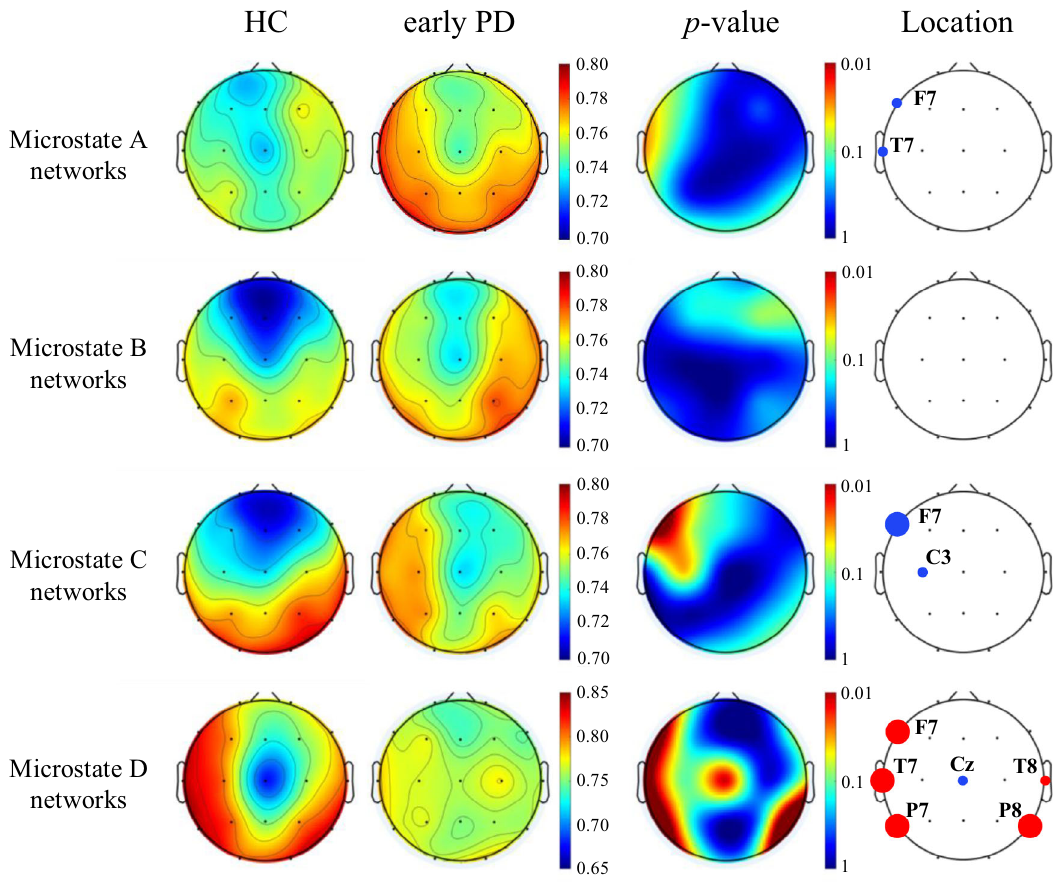
Fig. 3 Topological distribution of spatial variability of microstate functional connectivity networks (averaged over the subjects) for both groups and their differences in the four-microstate networks. The red points indicate the positions in which the spatial variability of microstate functional connectivity networks in healthy controls are obviously higher than that in early PD patients, and the blue points represent the positions that have lower spatial variability in healthy controls. The large points represent signi fi cant group difference ( p < 0.01, FDR corrected), and the small points indicate p < 0.05 with FDR